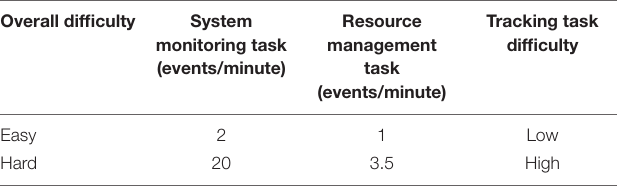
TABLE 2 | Task parameters for multi-attribute task